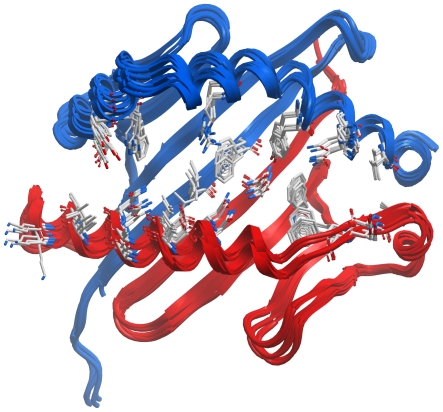
Similar HLA-DRB1*0101 peptide-contacting residue conformations observed in X-ray structures.All HLA-DRB1*0101 peptide-MHC complexes were superimposed by aligning the backbones of the MHC peptide binding domains (chain A residues 1–82 and chain B residues 1–92). MHC chains A and B are shown in red and blue ribbon representation, respectively. The MHC residues contacting the bound peptides, shown in stick representation, generally adopt similar conformations despite contacting different peptides. Much of the small side chain deviations are due to imperfect alignment of the MHC backbone atoms. This observation motivates the use of a rigid potential map representation of the MHC binding cleft in the docking procedure for efficiency rather than computationally expensive sampling of the contacting portion of the MHC.